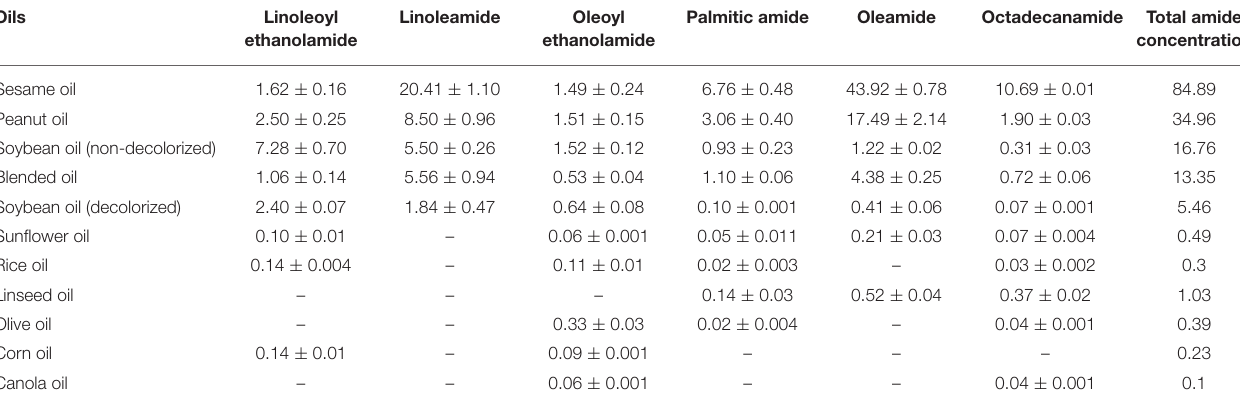
TABLE 3 | The content of six fatty acid amides found in 11 types of edible vegetable oil ( µ g/mL).